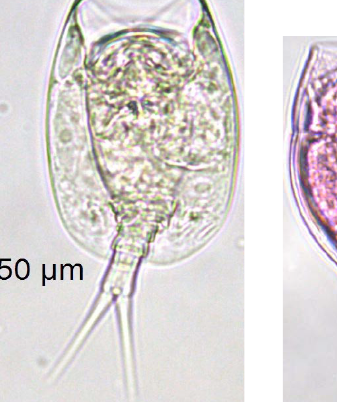
Image 12. Trichocerca scipio (Gosse) (lateral